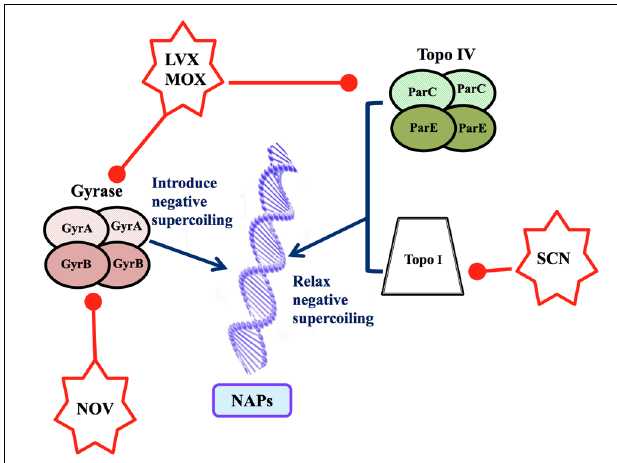
FIGURE 1 | Factors determining the topology of the Streptococcus pneumoniae chromosome. The level of supercoiling is controlled by three DNA topoisomerases. Gyrase (GyrA 2 GyrB 2 ) is inhibited by LVX, MOX (which inhibit GyrA) and NOV (which inhibits GyrB). Topo IV (ParC 2 ParE 2 ) is inhibited by LVX and MOX (which inhibit ParC). Topo I, a monomer, is inhibited by SCN. The topological organization of the chromosome depends on the level of DNA supercoiling and on the presence of